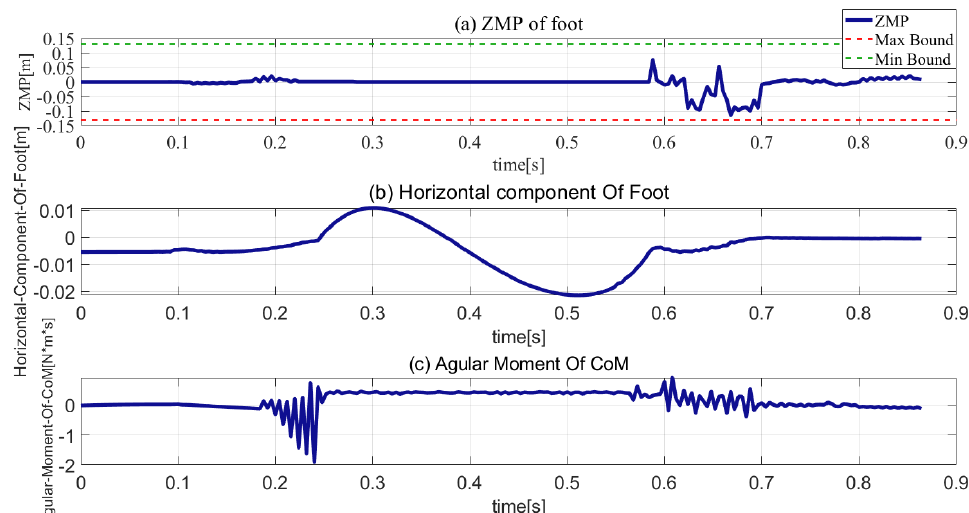
Figure 9. ZMP, horizontal foot position, and angular moment. The trajectories in the horizontal and vertical position of the CoM and the corre- sponding errors are shown in Figure 10. The sharp edges in the CoM and the correspond- ing errors were observed at the moment of touch-down owing to the touch-down impact. Because the CoM was not controlled during the flight phase, the CoM error disappeared in the flight phase. The CoM’s error trajectories indicate that the maximum error in the horizontal position was 0.038 m at 0.244 s, while that in the vertical position was 0.076 m at 0.212 s. Therefore, it is concluded that the response trajectories are in good agreement with previously obtained results.